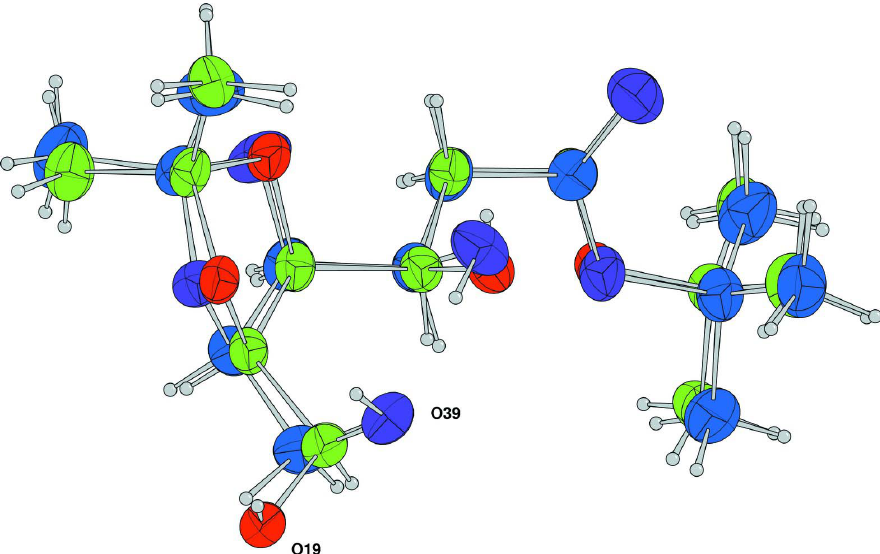
Figure 3 Overlay of the two molecules in the asymmetric